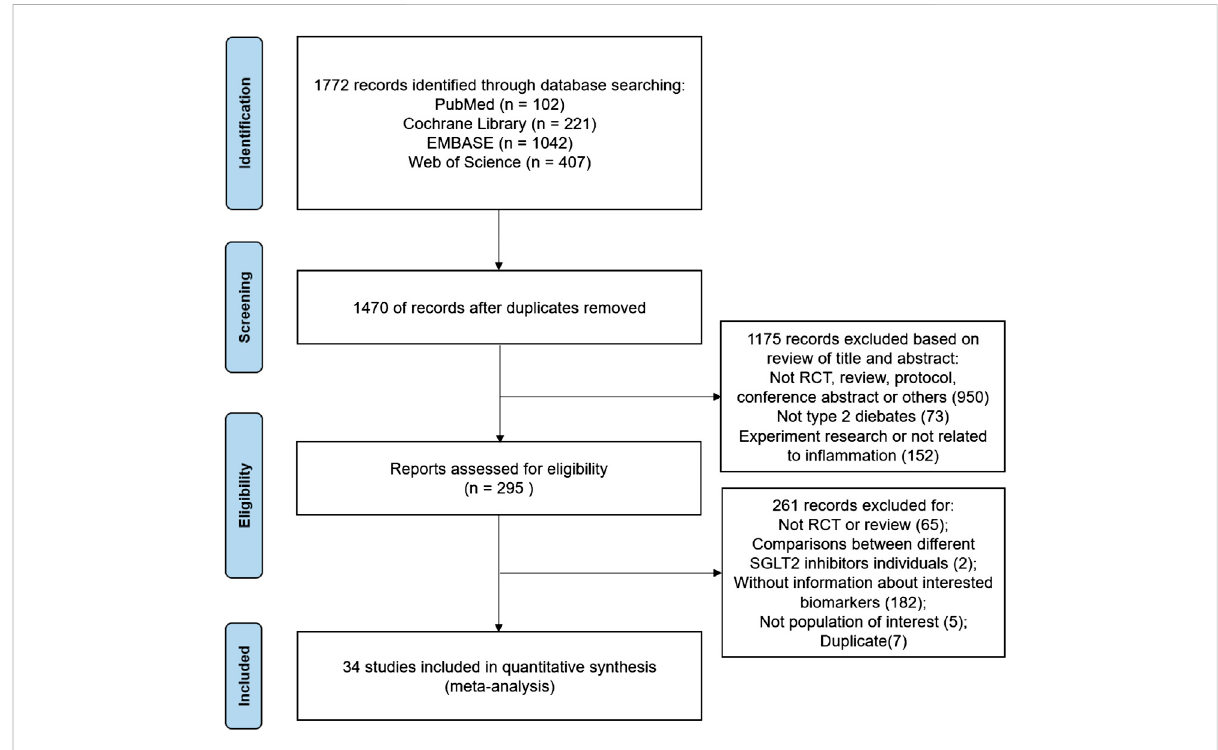
The process of study